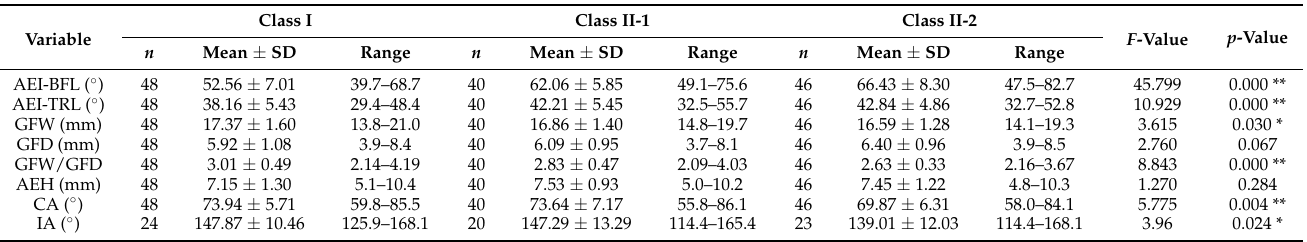
Table 2. Measurements of the temporomandibular joint osseous morphology according to the malocclusion.